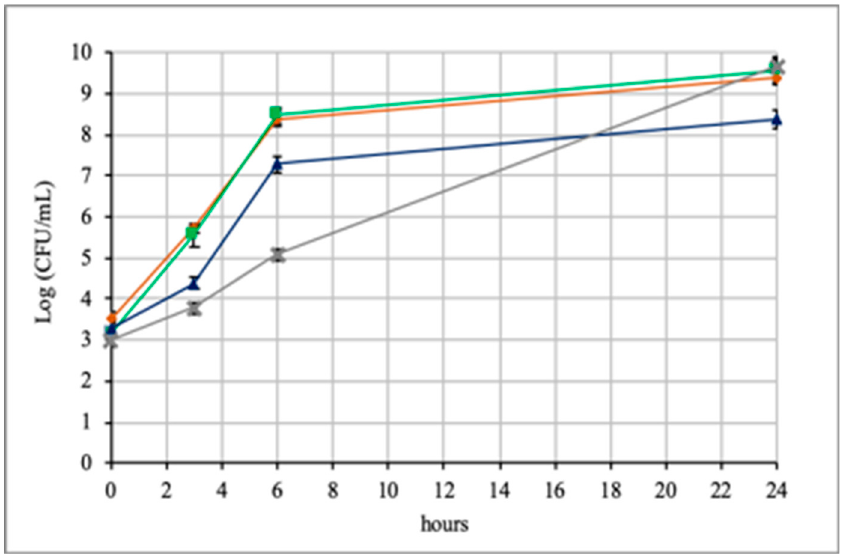
Figure 1. Growth of A. muciniphila DSM 22959 and Lb. rhamnosus GG in co-culture ( A. muciniphila = ▲ ; Lb. rhamnosus = ■ ; A. muciniphila in co-culture = X ; Lb. rhamnosus in co-culture ◆ ).